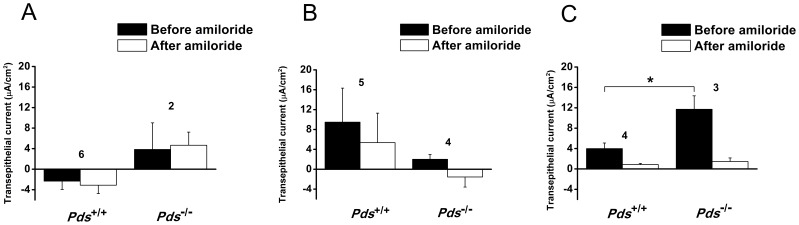
Difference of trans-epithelial current in the saccular extramacular roof epithelium at P0 (A), P6 (B), and P56 (C).The trans-epithelial current at P0 and P6 in the mice was not significantly inhibited by 10 µM amiloride. The current was not significantly different between the Pds
+/+ and Pds
−/− mice. However, amiloride-sensitive current was detected at P56, and the current was significantly increased at P56 in the Pds−/− compared with Pds+/+ mice. *p<0.05, numbers above the bars represent the number of trans-epithelial current measurements.